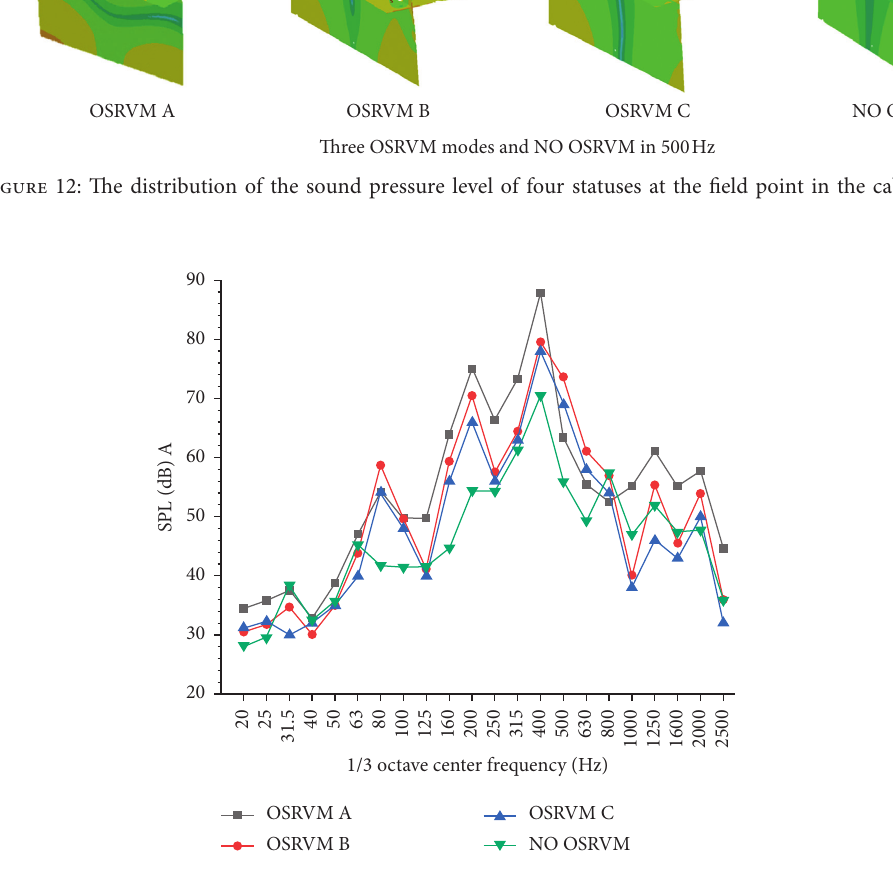
Figure 13: Comparison of sound pressure levels in the driver’s left ear of three OSRVMs and NO